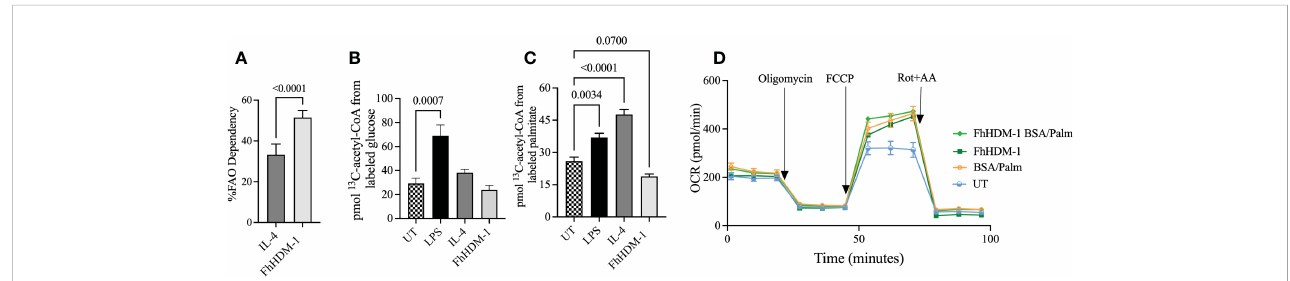
FIGURE 2 Oxidative phosphorylation induced by FhHDM-1 has a greater dependency on fatty acids than IL-4 driven metabolic activity. (A) The dependency of cells on fatty acids as fuel for mitochondrial respiration was determined by measuring the OCR in cells treated with either IL-4 (20ng/ml) or FhHDM-1 (2.5µM) in the presence of inhibitors of fatty acid oxidation or glycolysis and glutamine. (B, C) The incorporation of 13 C into acetyl-CoA was determined by mass spectrometry analysis of BMDMs that had been untreated (UT) or cultured with FhHDM-1 (2.5µM), IL-4 (20ng/mL), or LPS (20ng/mL) for 24h followed by 1h in the presence of 13 C 16 -potassium palmitate of 13 C 16 -glucose (n=6). (D) The ability of cells to utilise exogenous fatty acids was determined by measuring the OCR levels in BMDMs cultured with 2.5µM FhHDM-1 in the presence of BSA/Palmitate (n=4). Statistical signi fi cance was determined by either an unpaired, two tailed Welch ’ s t-test or a one-way ANOVA with Tukey ’ s multiple comparison test. Data is representative of two- fi ve independent experiments and is presented as means ±